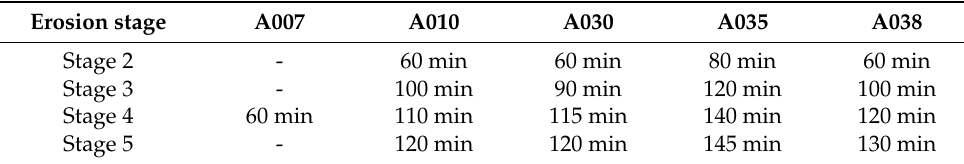
Table 2. Time in RET rig to reach erosion stage for different test